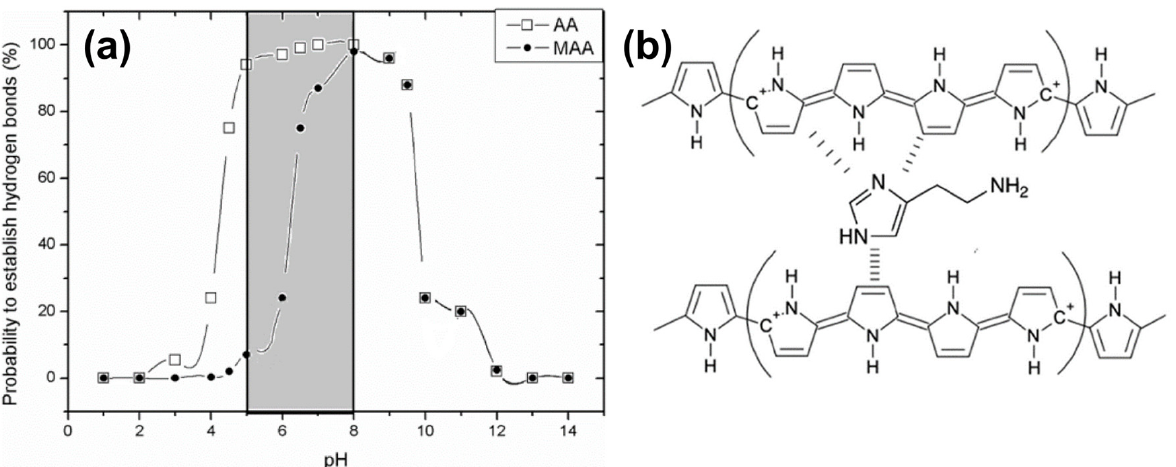
Figure 9. ( a ) Combinatorically calculated pH dependence of the binding probability between histamine and MIPs synthesized from acrylic acid (AA, open boxes) and methacrylic acid (MAA, solid dots) based on the variety of protonation states of the target molecule and the MIP receptors. Reprinted with permission from ref. [196]. Copyright 2013 American Chemical Society. ( b ) Structure of the conducting polymer polypyrrole (PPy) with a histamine molecule trapped by π – π stacking, this interaction is reversible and independent of the pH value of the sample. Reprinted from ref. [197]. Copyright 2021 American Chemical